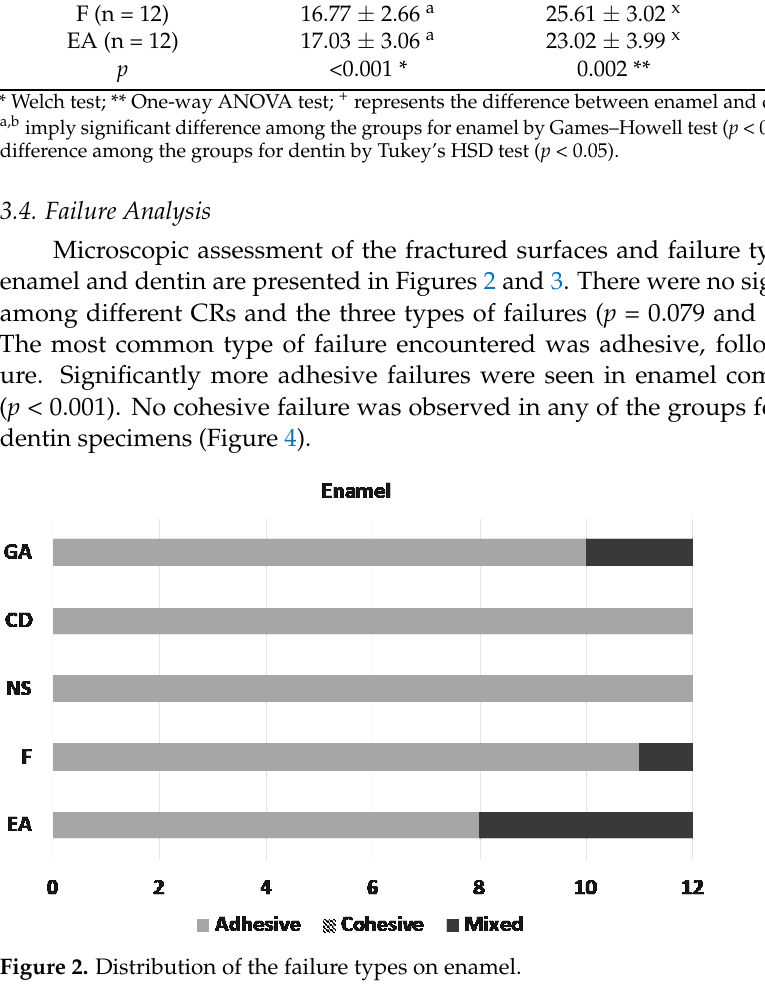
Figure 3. Distribution of the failure types on dentin.